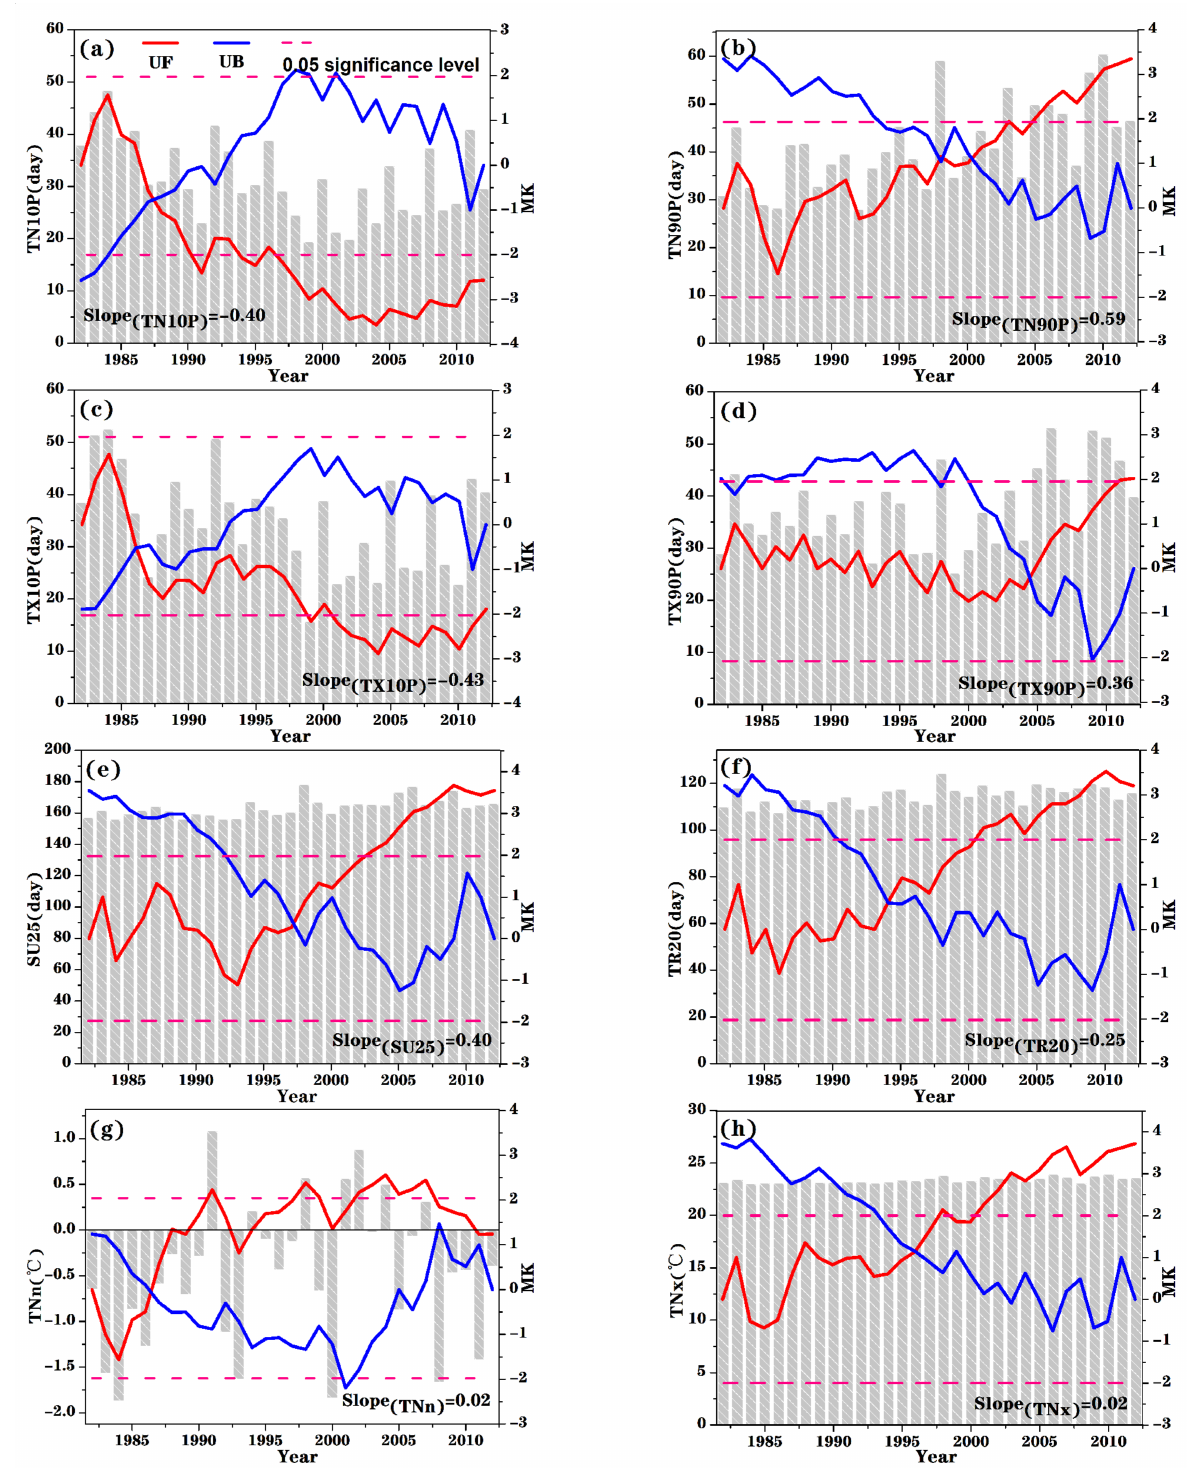
Figure 2. Interannual trends in extreme temperature indices on the Mongolian Plateau over the last three decades.(Temporal trends of each extreme temperature index, ( a ) TN10P: Cold nights, ( b ) TN90P: Warm nights, ( c ) TX10P: Cold days, ( d ) TX90P: Warm days, ( e ) SU25: Hot summer days, ( f ) TR20: Nights stay hot, ( g ) TNn: An extremely low daily minimum temperature, ( h ) TNx: An extremely high daily minimum